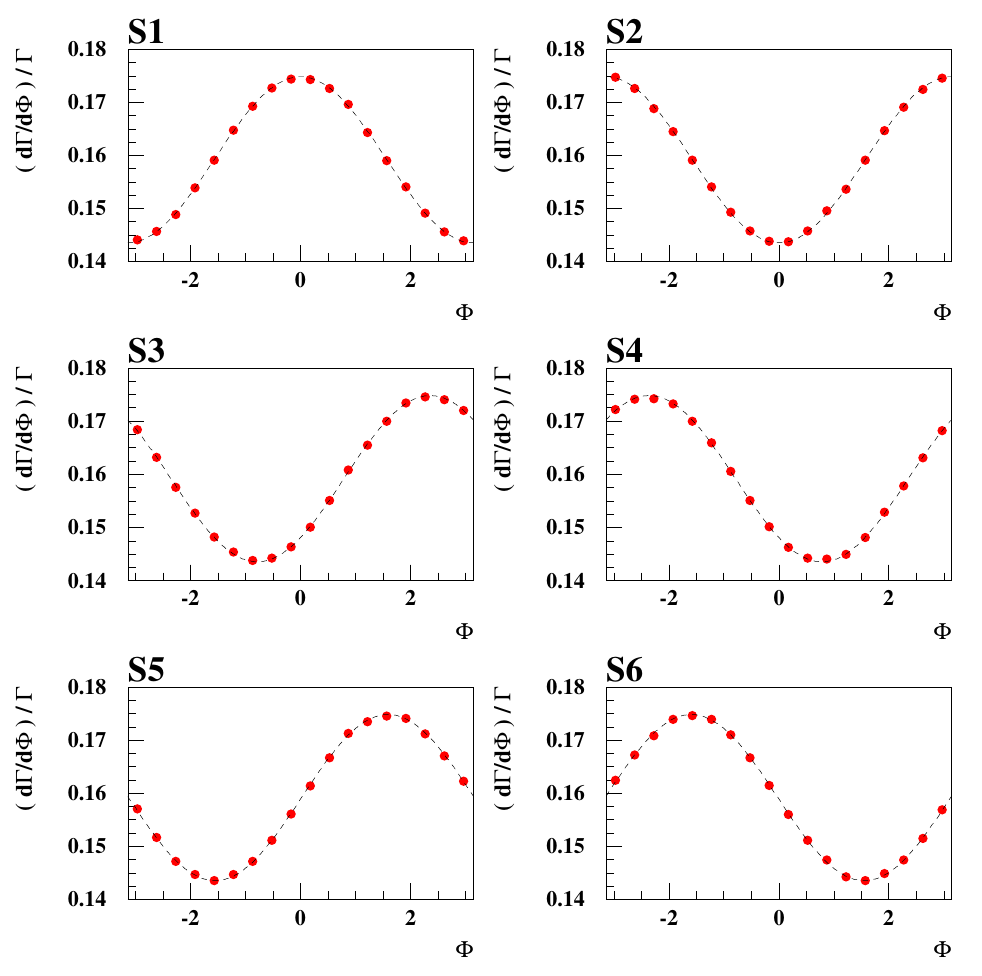
Figure 1 . The normalized angular distributions (solid dots) generated according to eq. (2.15) p p integrating over m t (cid:0) 5 (cid:0) t (cid:20) p 2 (cid:20) m t + 5 (cid:0) t and m t (cid:0) 5 (cid:0) t (cid:20) (cid:22) p 2 (cid:20) m t + 5 (cid:0) t . We have t t (cid:0) (cid:1) taken f L = 1 and f R = 0. In each frame, we are taking g S ; g P = (1 ; 0) ( S1 : upper-left), (cid:0) (cid:1) (cid:0) (cid:1) (cid:0) (cid:1) g S ; g P = (0 ; 1) ( S2 : upper-right), g S ; g P = (1 ; 1) ( S3 : middle-left), g S ; g P = (1 ; (cid:0) 1) ( S4 : (cid:0) (cid:1) (cid:0) (cid:1) middle-right), g S ; g P = (1 ; 0 : 42) ( S5 : lower-left), and g S ; g P = (1 ; (cid:0) 0 : 42) ( S6 : lower-right). The dashed lines are drawn using the expressions in eq. (2.32), which are obtained in the m b = 0 limit, taking w i =